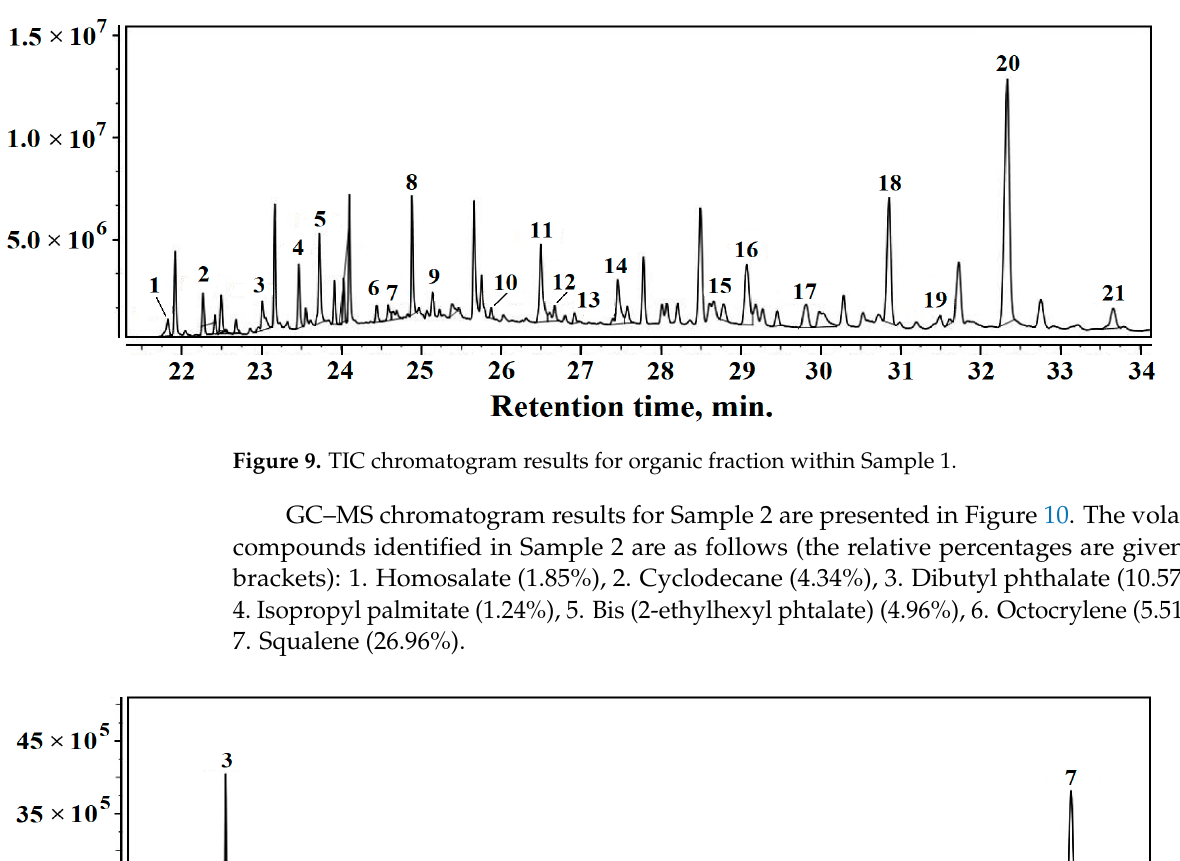
Figure 11. TIC chromatogram resulted for organic fraction within Sample 3. The dominant organic volatile compound in all three samples is squalene, which confirms the sediment origins in the amphora’s ancient content. Unfortunately, squalene is reported in the literature to have a strong connection with not only wine residue [40,41] but also olive oil [42,43]. Thus, several volatile compounds such alcohol residue, such as 1-Hexadecanol and 1-Dodecanol, 2-octyl and several alkanes such astridecane, teradecane and heptadecane were found in Samples 1 and 3 which do not appear in Sample 2. These are also related to the distillation process and wine residue, and data in the literature relate their presence to some sorts of wine [44–47]. The wine residue related to volatile compounds found in Samples 1 and 3 is accompanied by moderate amounts of oil derivatives, which are characteristic of Sample 2. It presents a combination of organic derivatives such as homosalate, isopropyl palmitate, and octocrylene, which are long related to olive oil, decomposing in the presence of alkaline minerals such as calcite and muscovite. No traces of wine-related alkanes were found in Sample 2. Chassouant shows that, in Roman times, amphora fragments were deposited all together in special places [41]. Contact between different